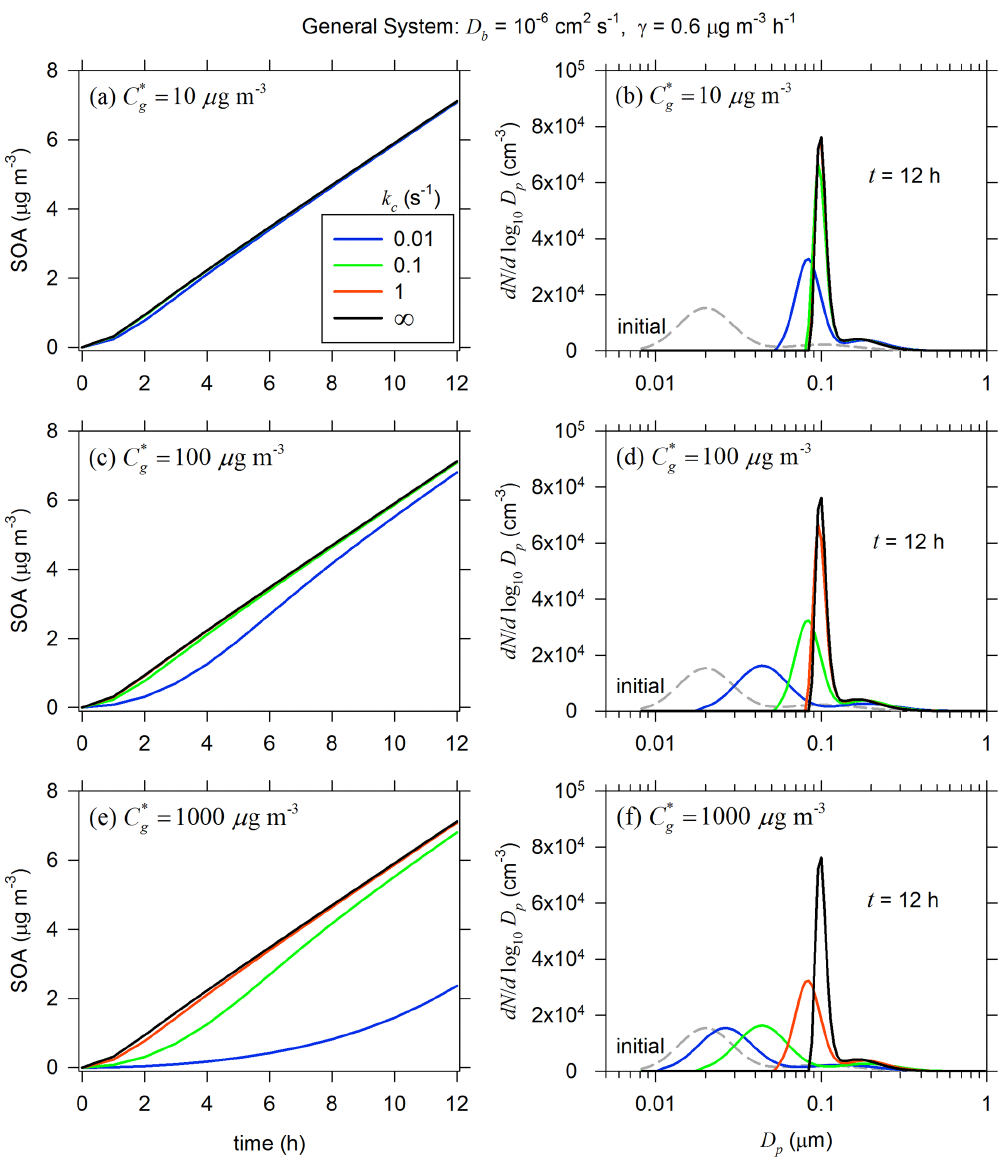
Figure 18. Temporal evolution of total SOA mass concentration (left column) and aerosol size distribution (right column) at t = 12h for D b = 10 − 6 cm 2 s − 1 , γ = 0.6µgm − 3 h − 1 , k c = 0.01 to ∞ s − 1 , and three different solute volatilities: (a, b) C ∗ g = 10µgm − 3 , (c, d) C ∗ g = 100µgm − 3 , and (e, f) C ∗ g = 1000µgm − 3